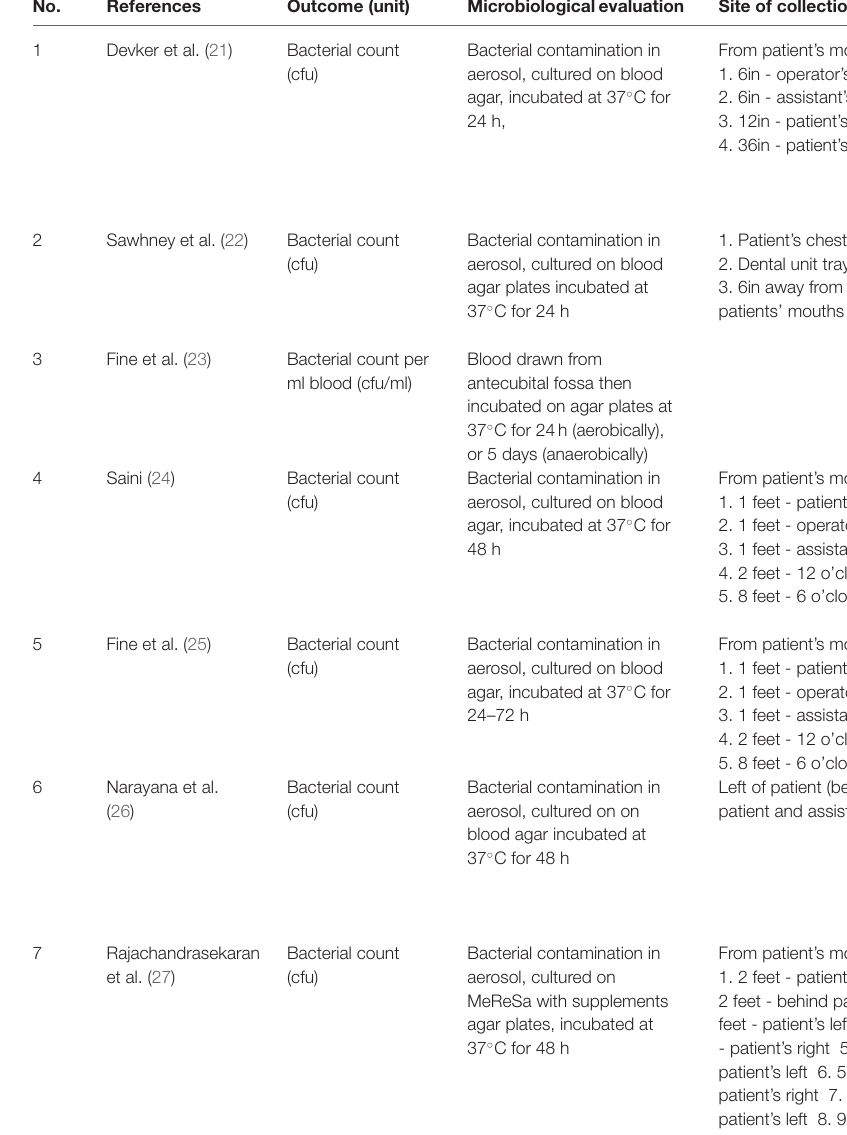
TABLE 2 | Pre-procedural rinse study main findings (Ctd).